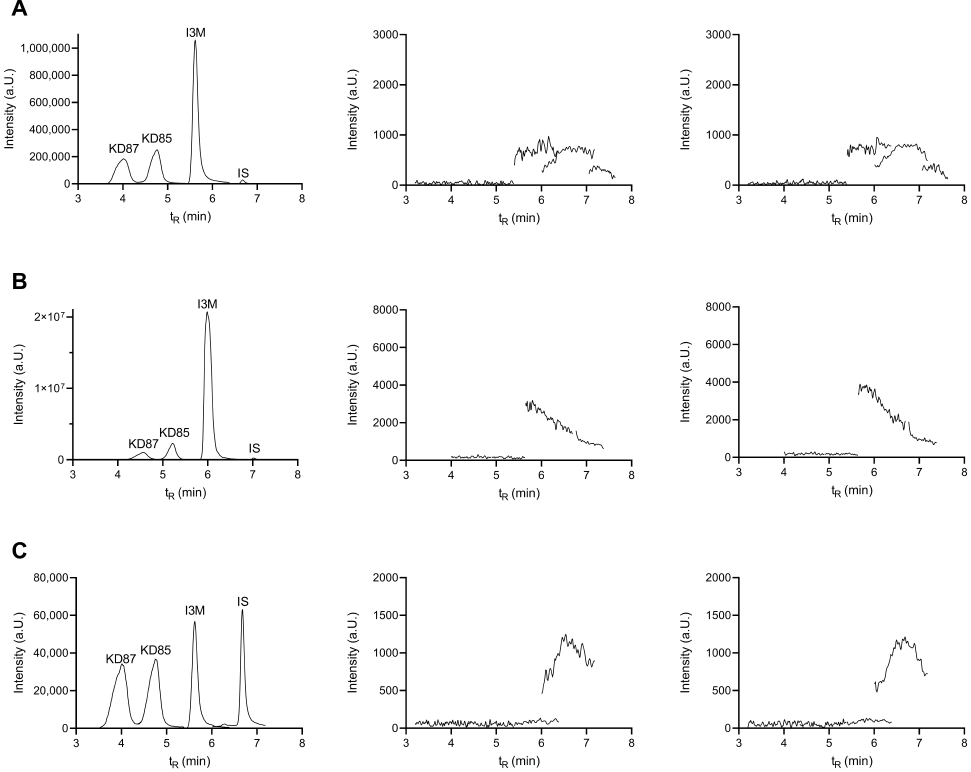
Figure 3. Representative total ion chromatograms (TIC) for ( A ) carryover after plasma precipitation at 333 nM, ( B ) carryover after extraction from plasma at 500 nM, and ( C ) carryover after extraction from DMEM at 50 nM. The indirubin concentration was always 50 nM. Shown on the left are the TIC for all analytes (elution order listed in Table 1). Shown in the middle is the TIC of a blank run with acetonitrile/water (50/50) after one injection of sample. Shown on the right is the TIC of a blank run with acetonitrile/water (50/50) after double injection of the sample. The injection volume was always 10 µ L. TIC are shown in ESI+ except for DMEM extracted I3M (ESI −